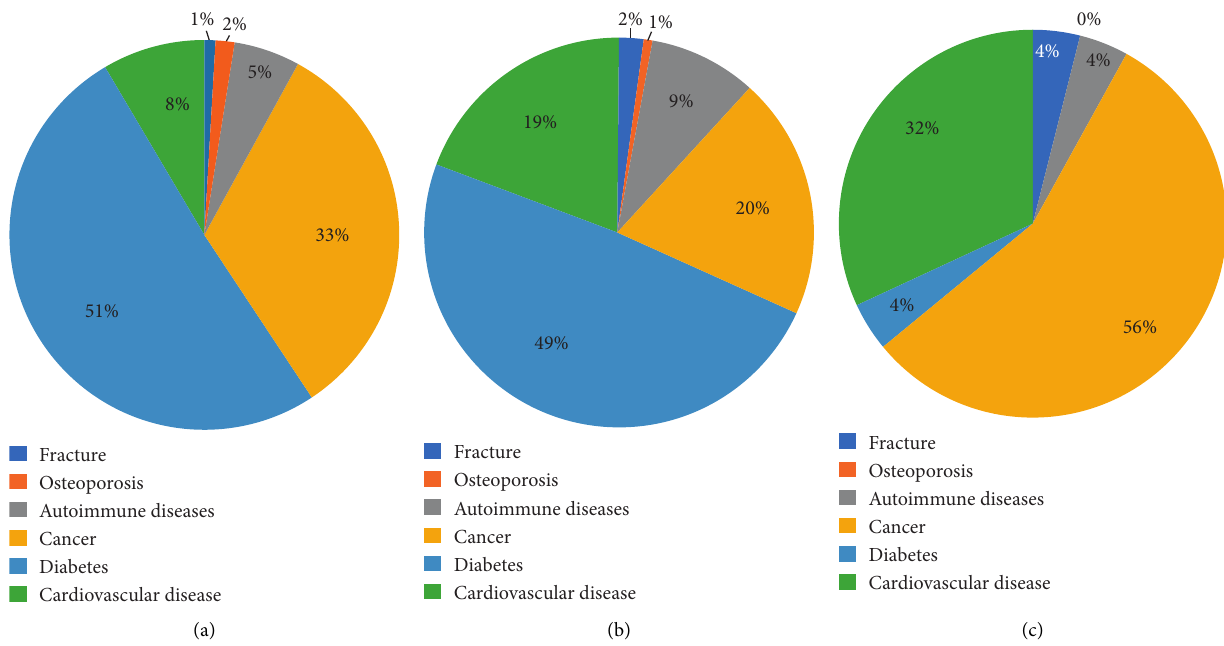
Figure 7: Distribution of clinical samples from men. (a) BGP < 10ng/mL. (b) BGP within 10–40ng/mL. (c) BGP > 40ng/mL.